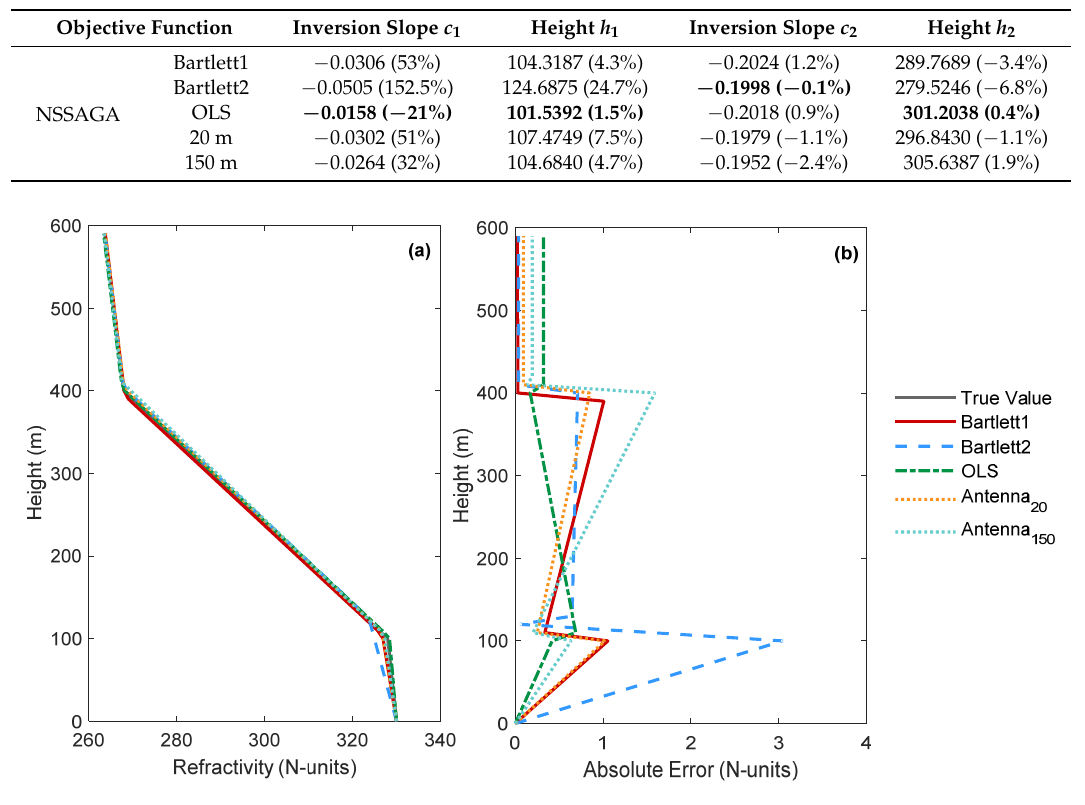
Figure 9. Comparison of retrieved refractivity profile and absolute error by NSSAGA with various objective functions.